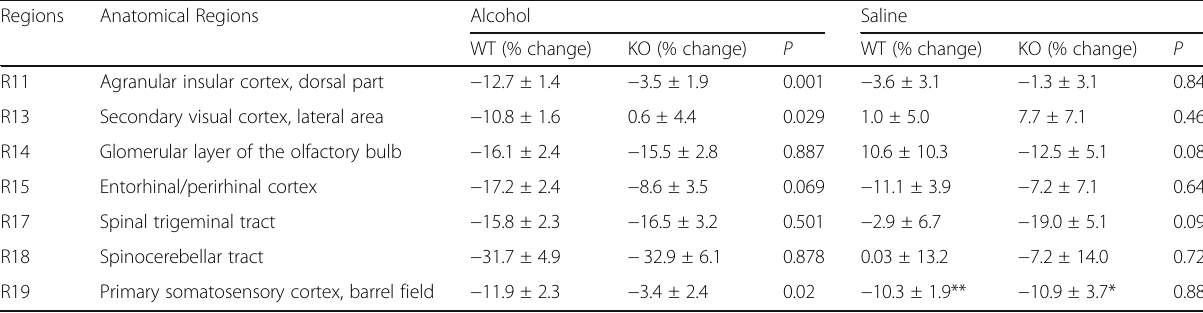
Table 4 Regional metabolic activity in regions identified in the WT mice after binge alcohol. Percent changes in regional metabolic activity in the WT and CIRP − / − mice treated with alcohol or normal saline (mean ± SE). * P < 0.05 and ** P < 0.01 between pre- and post-saline treatment within groups